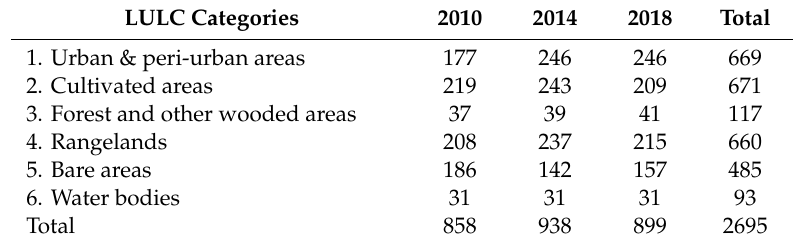
Table 2. Number of samples of each LULC class used to train the classifier in 2010, 2014, and 2018.